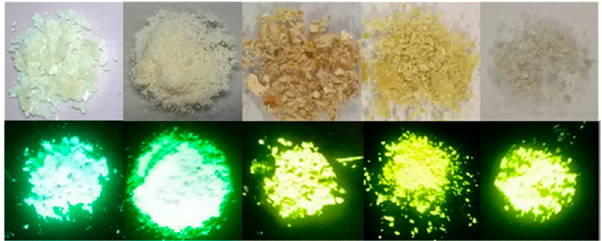
Figure 4. Photographs of HBO 1 – 5 (from left to right) as powders under daylight ( top ) and under irradiation at λ exc = 365 nm ( bottom ).